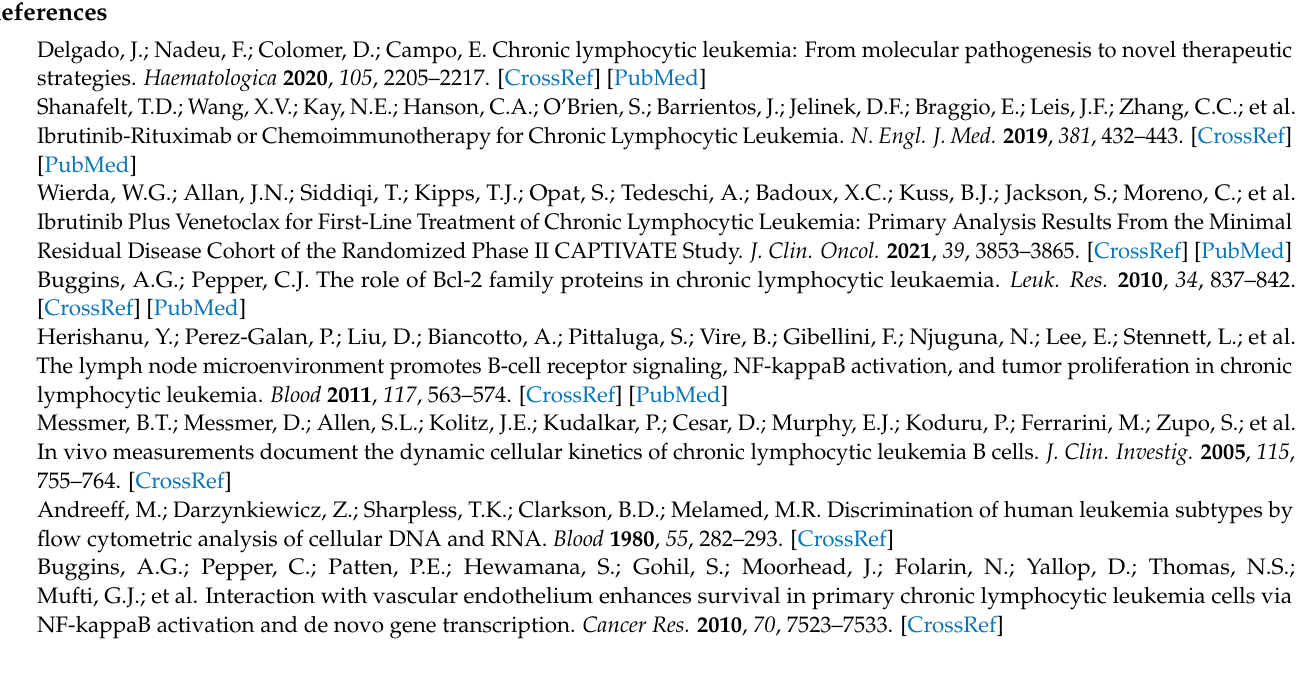
ibrutinib treatment; Table S1: Antibodies used; Table S2A–F. Immunophenotypic characterization of the patient samples used in each